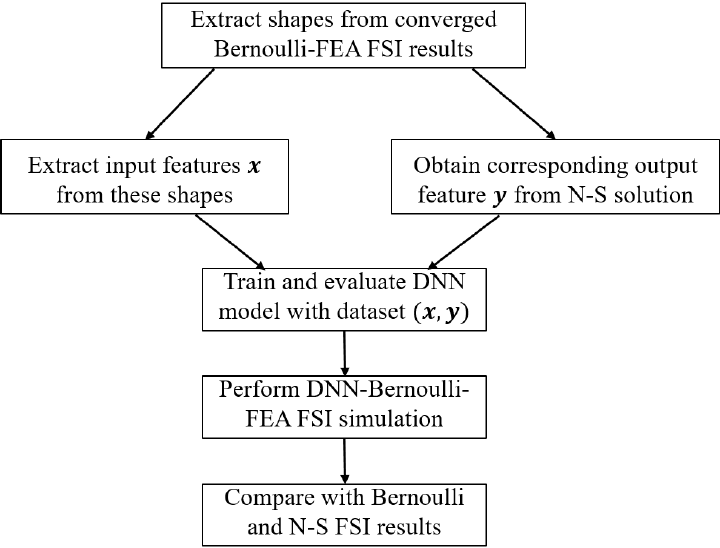
Figure 7. Workflow of the DNN-Bernoulli model for fluid structure interaction (FSI) simulation.